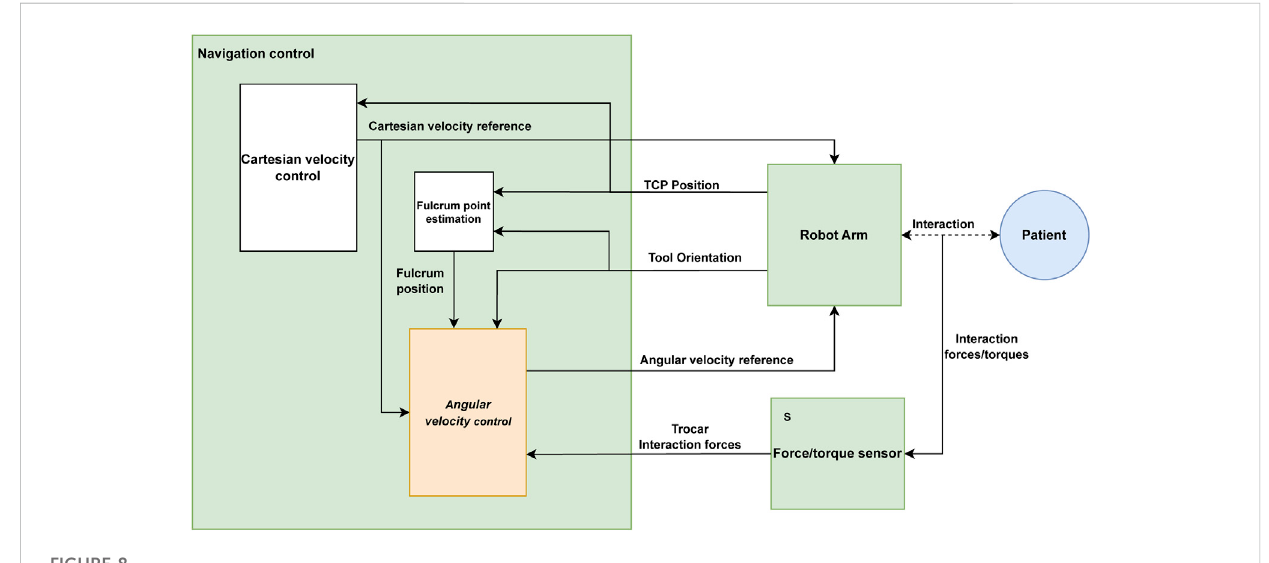
FIGURE 8 ROS implementation diagram of the robot